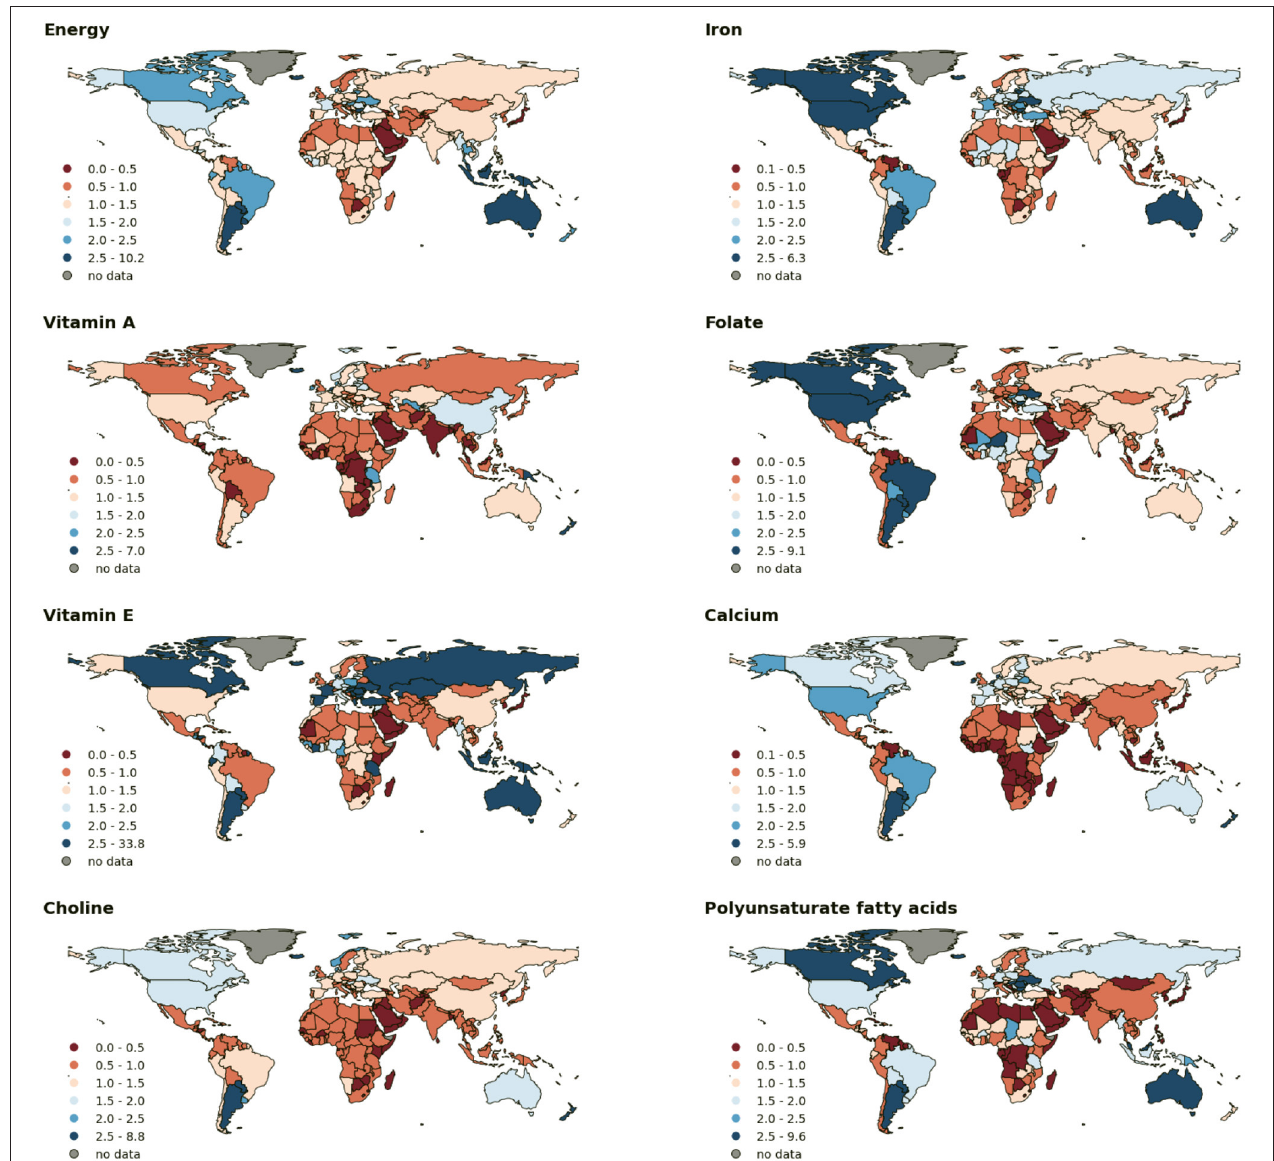
FIGURE 1 | Country-specific Nutrient Production Adequacy ratios for eight selected nutrients. The numbers show the average production adequacy across 2011–2014. For a given nutrient, countries in darker red colors present lower adequacy in food production as compared to their national population requirement. Map breaks at a fixed interval in the range of 0.5–2.5 and extend to the minimum and maximum values out of this range for each nutrient.